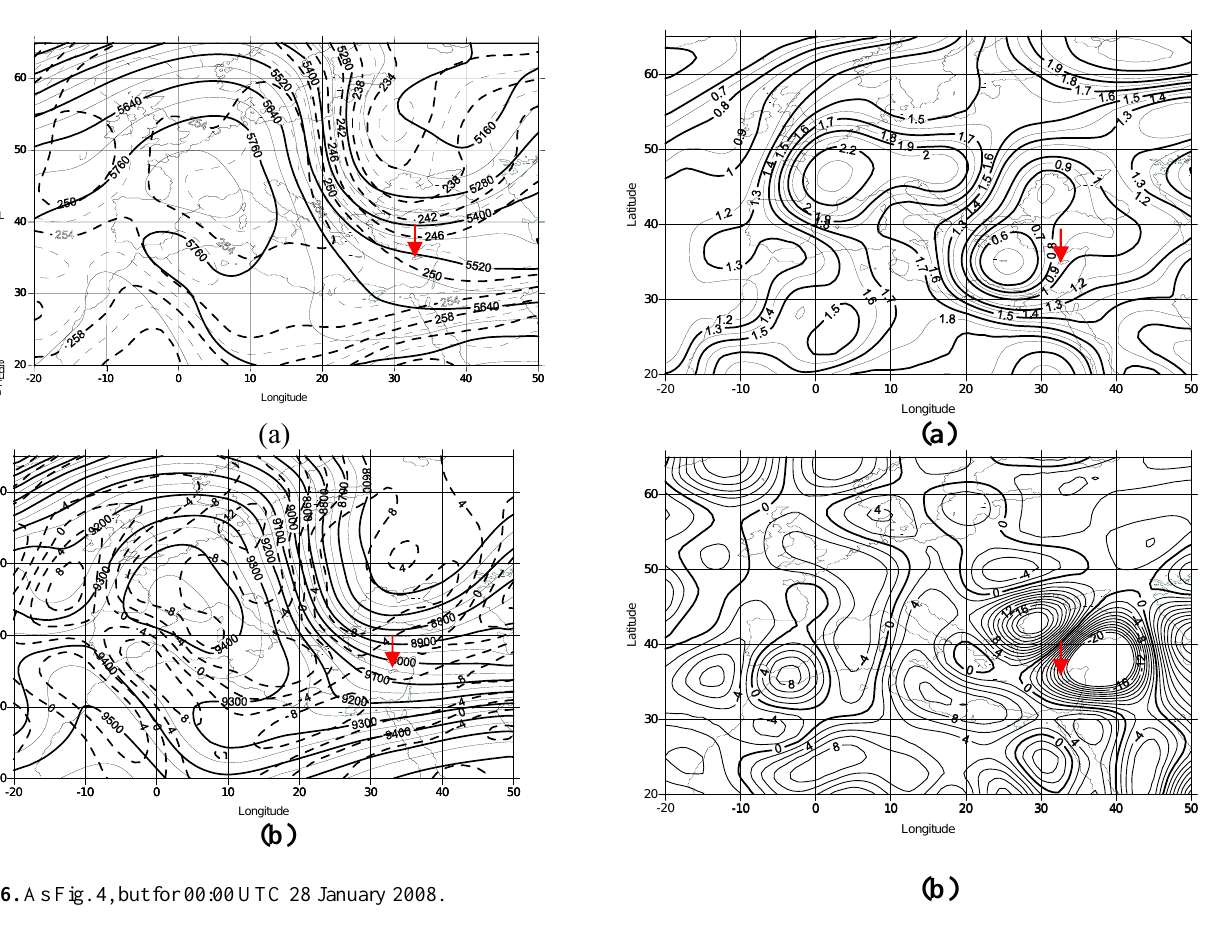
Fig. 7. As Fig. 3, but for 0000 UTC 29 January 2008.